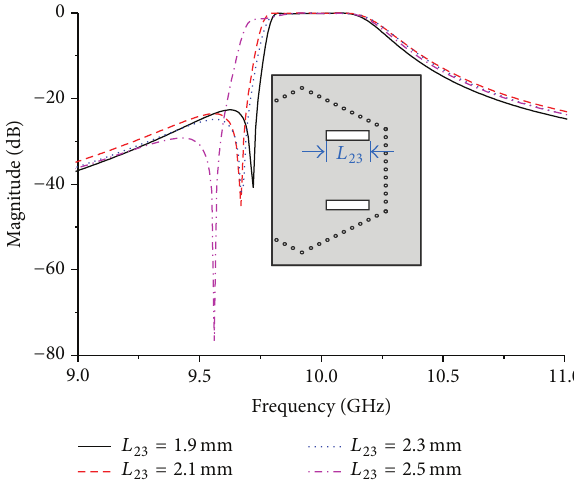
Figure 4: Effect of coupling window’s length on transmission zero in filter